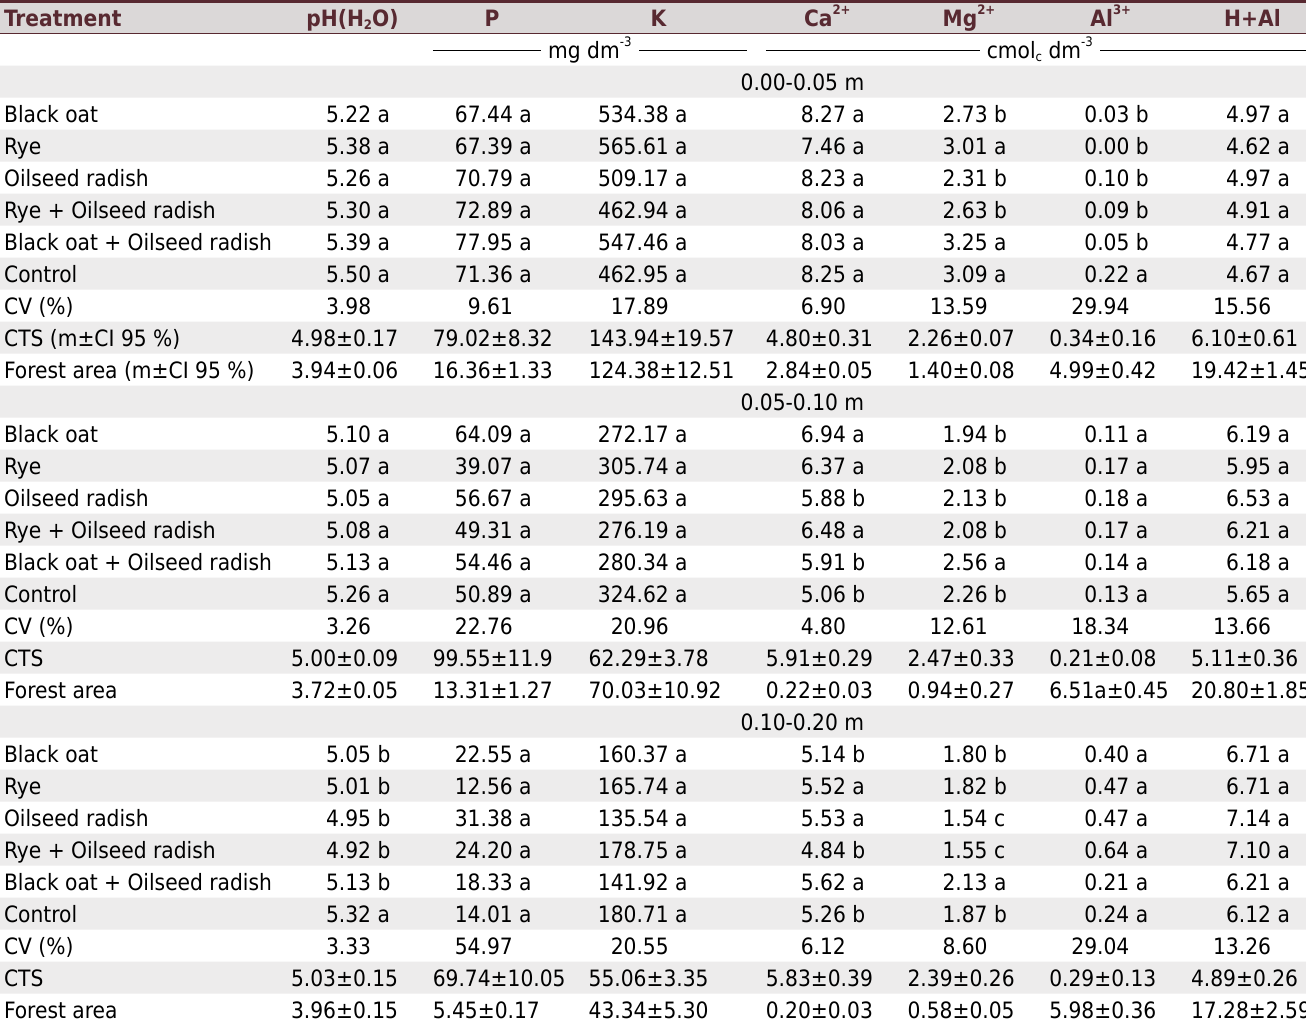
Table 1. Chemical properties of the macroaggregates of a Humic Dystrudept cultivated with onion under no-till compared to conventional tillage